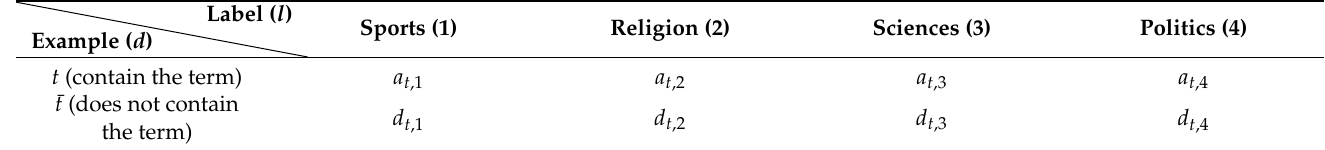
Table 4. Variables used for weighting in a multilabel problem, given a term t and 4